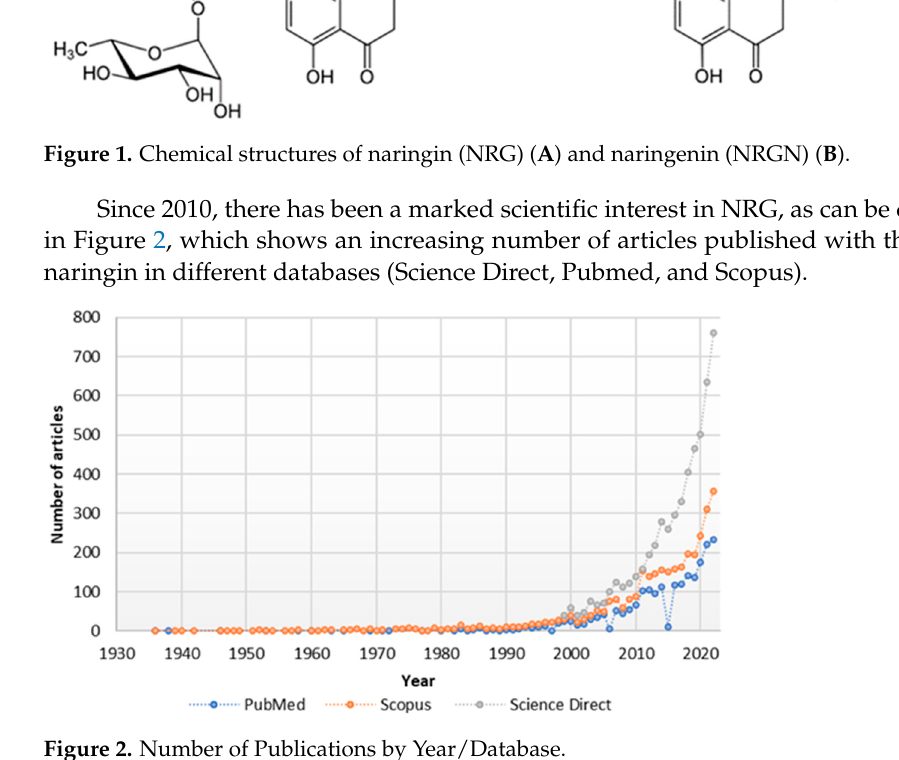
Figure 2. Number of Publications by Year/Database.